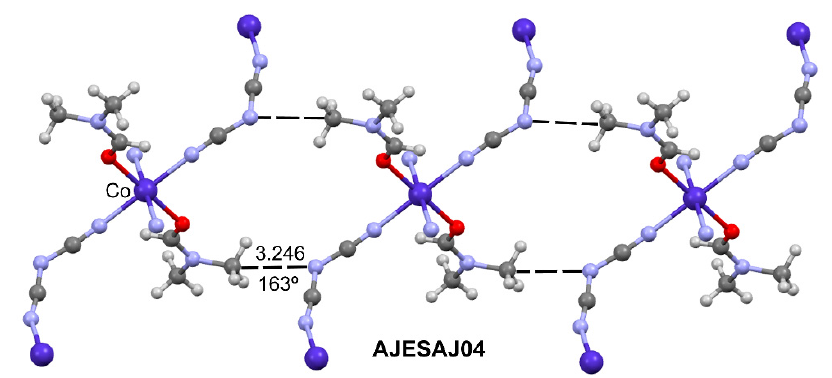
Figure 8. X-ray structures of CSD refcodes AJESAJ06. Distance in Å is given adjacent to the dashed lines used to represent the TtBs.